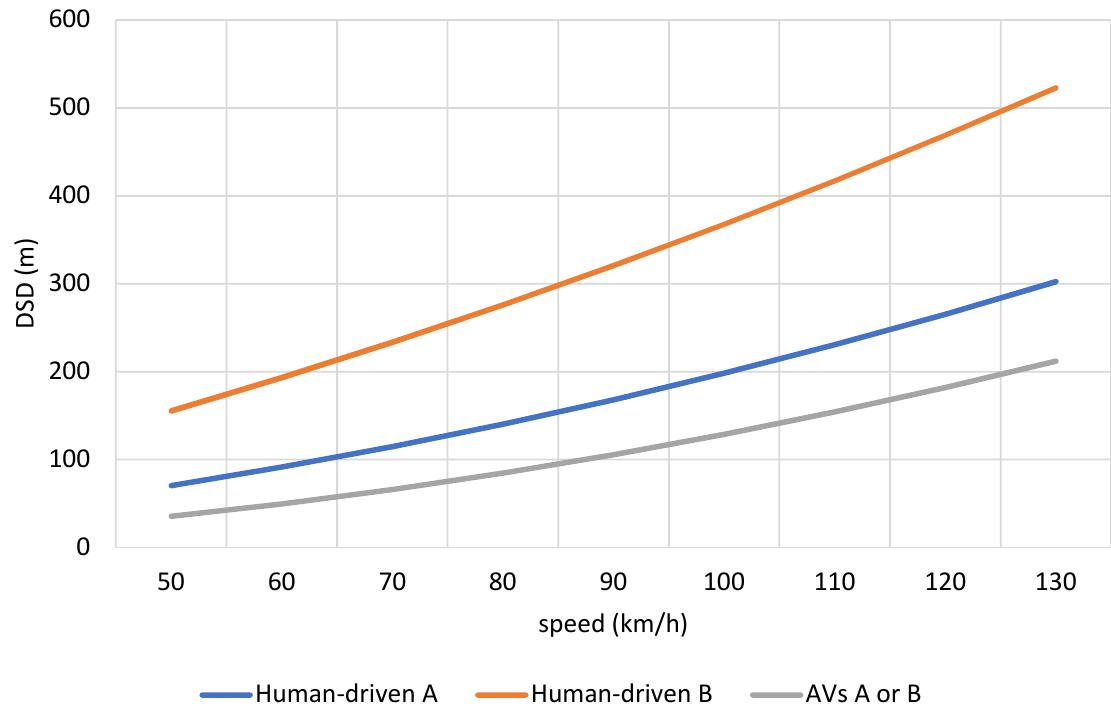
Figure 4. Decision sight distance for the two scenarios A and B for both human-driven and autonomous vehicles.